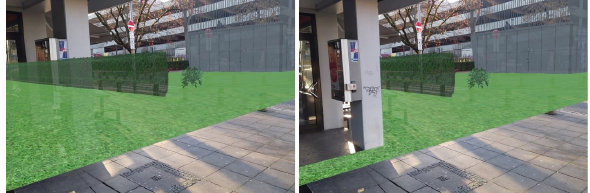
Figure 7. Occlusion screening based on the 3D building model. ( left ) Disabled. ( right )